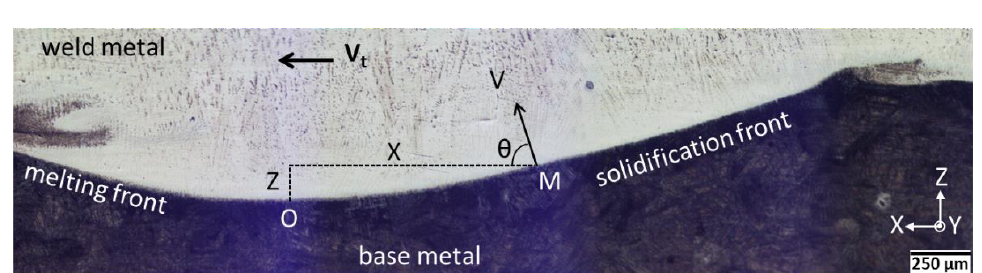
Figure 1. Optical micrograph of a longitudinal section in a single-layer weld. V t and V refer respectively to the travel speed of the strip electrode and the local solidification velocity at a point M on the liquid-solid interface.